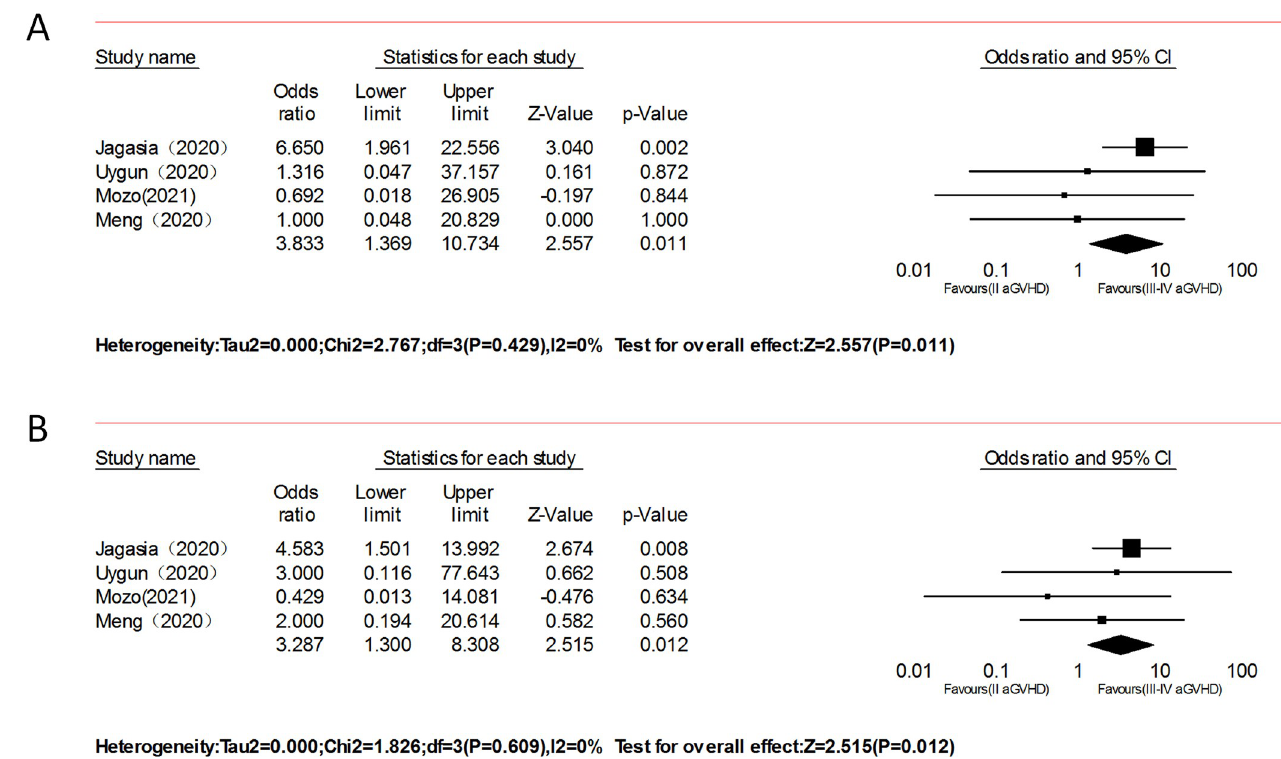
Fig 7. Forest plots of the overall response (ORR) of Grade II vs. Grade III–IV after ruxolitinib therapy.